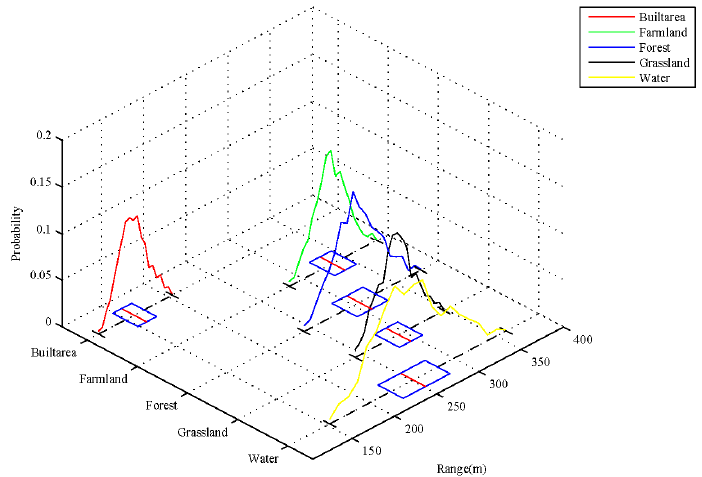
Figure 6. Probability distributions for the built area ( red ), farmland ( green ), forest ( blue ), grassland ( black ), and water ( yellow ).